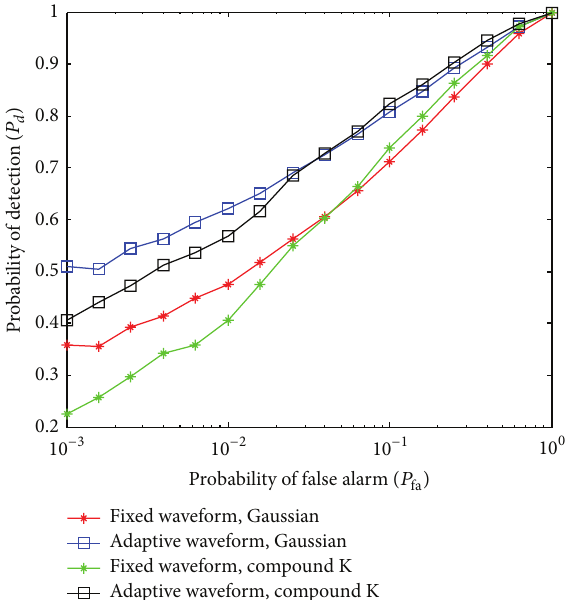
Figure 11: Comparison of detection performance with fixed and adaptive waveform in Gaussian and compound K-distribution clutter ( 𝑃 = 3